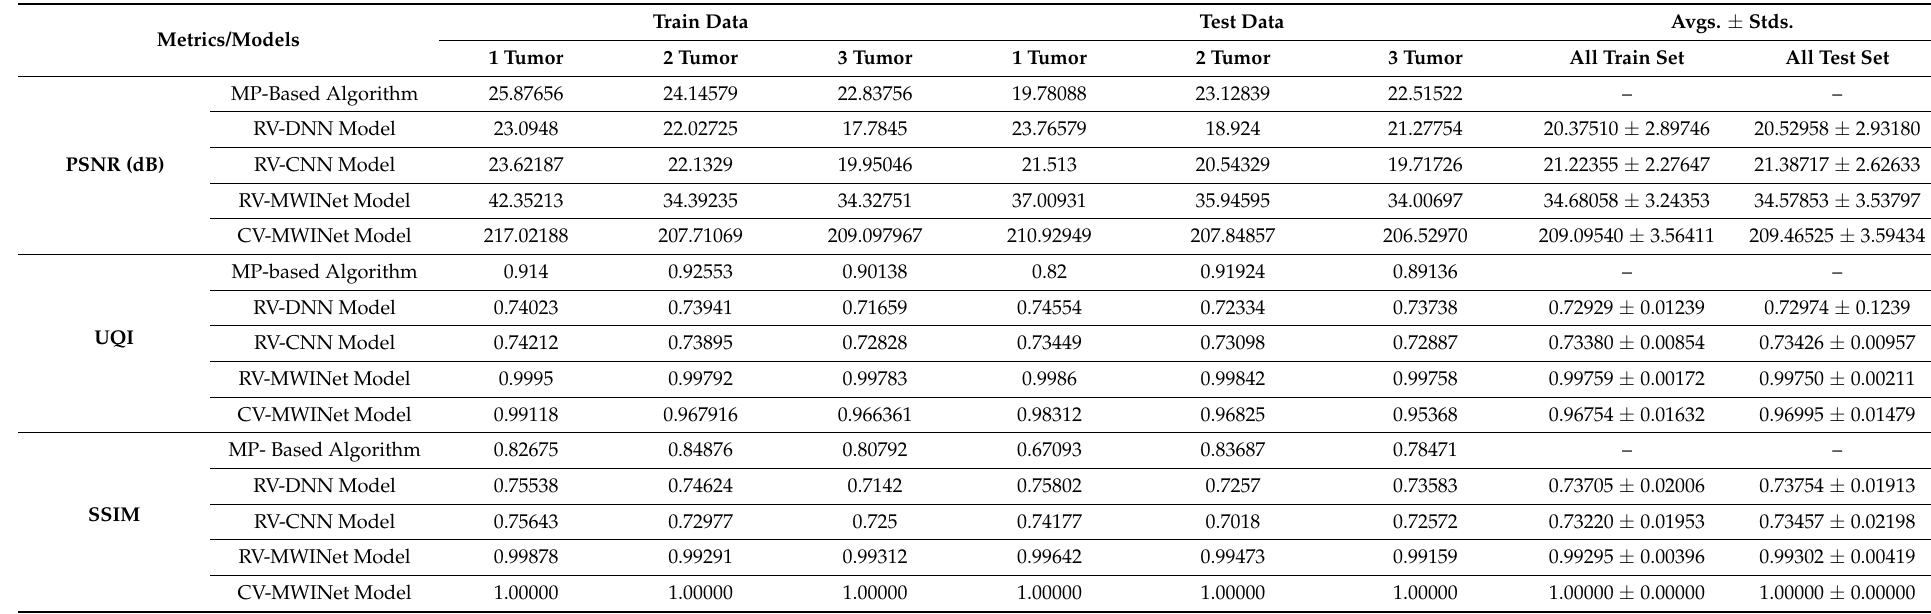
Table 6. Performance metrics of the proposed neurocomputational models for the images given in Figures 9 and